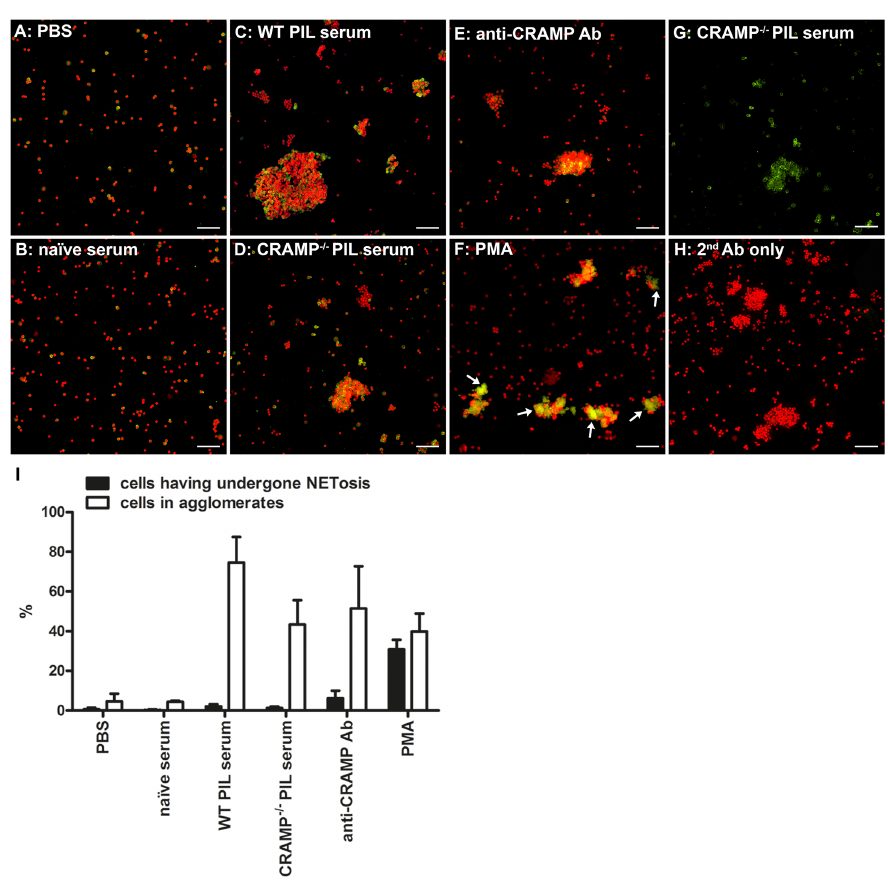
Fig. 10. Lupus antibodies induce agglomeration of mouse blood cells but no NETosis. Representative fluorescence microscopy images and morphometry of murine blood cells incubated with various stimuli/ controls and stained for DNA (DAPI, red) and neutrophil elastase (green). Incubation with PBS (A), IgG purified from naı¨ve WT mice (B), IgG purified from PIL anti-CRAMP positive sera from WT mice (C), IgG purified from PIL anti-CRAMP-negative sera from CRAMP 2 / 2 mice (D), purified anti-CRAMP antibody (E), or PMA (F). The picture in (G) shows only NE-staining and reveals strictly cytoplasmatic expression of NE. Control stainings were performed using secondary FITC-conjugated Ab only (H). Scale bars, 100 m m. Neither incubation with IgG isolated from serum nor incubation with purified anti-CRAMP antibody induced NETosis, identifiable from extracellular washy DNA colocalizing with NE (as shown in F, white arrows). However, IgG from mice with PIL induced agglomeration of blood cells. (I) Quantification of the percentage of cells in aggregates . 5x mean nuclear size and of cells having undergone NETosis. Bars show the mean and SD of 3 pictures for each treatment condition.